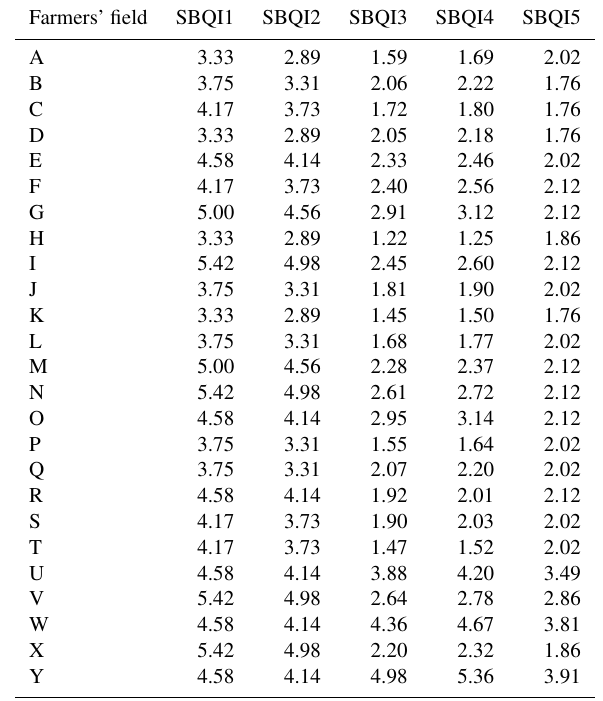
SBQI1 to SBQI5 represent the unitless 10-scaled values of the soil biological quality index calculated for the farmers’ field soil using different methods as described earlier. Details of farmers’ field soils are provided in Table S1 in the Supplement.